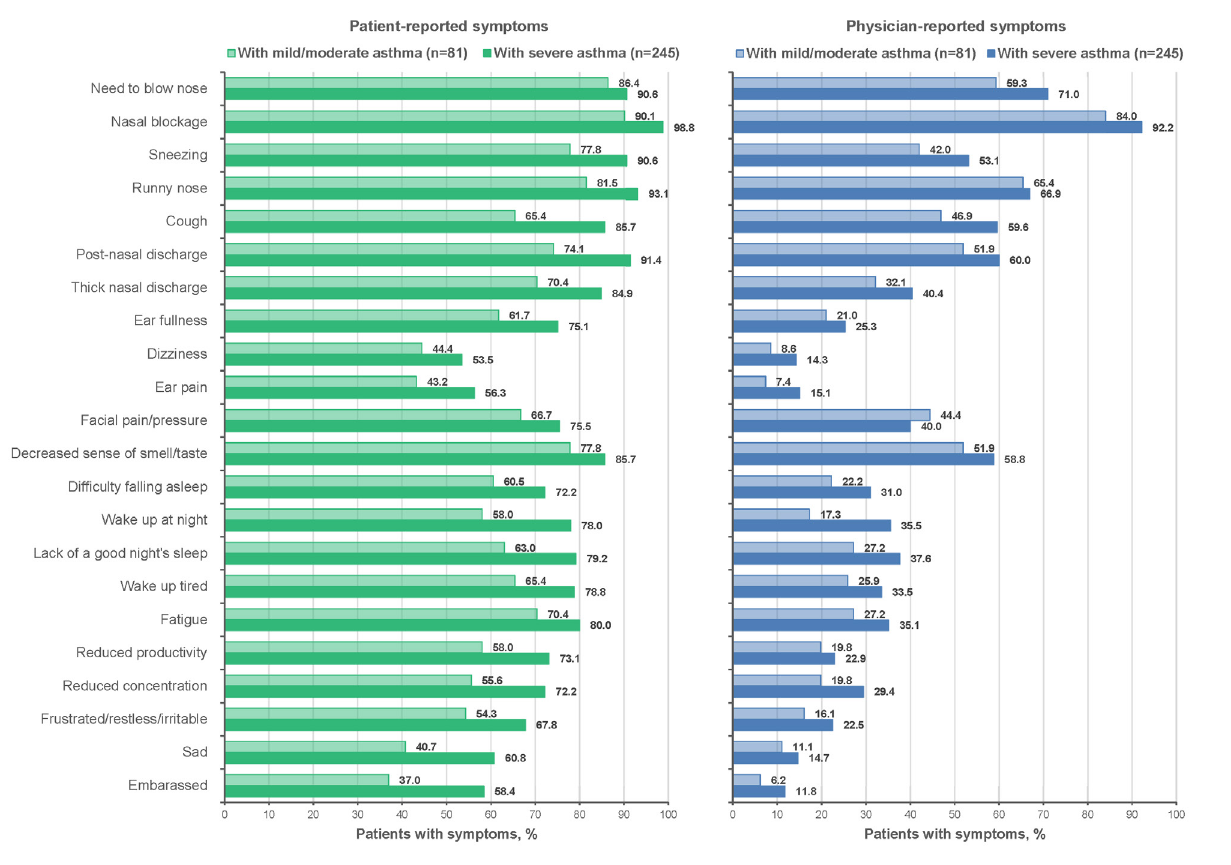
Supplemental Figure 2. Prevalence of reported CRSwNP symptoms from matched patient/physician perspectives by categories of comorbid asthma severity (total sample with comorbid asthma). Abbreviation: CRSwNP, chronic rhinosinusitis with nasal